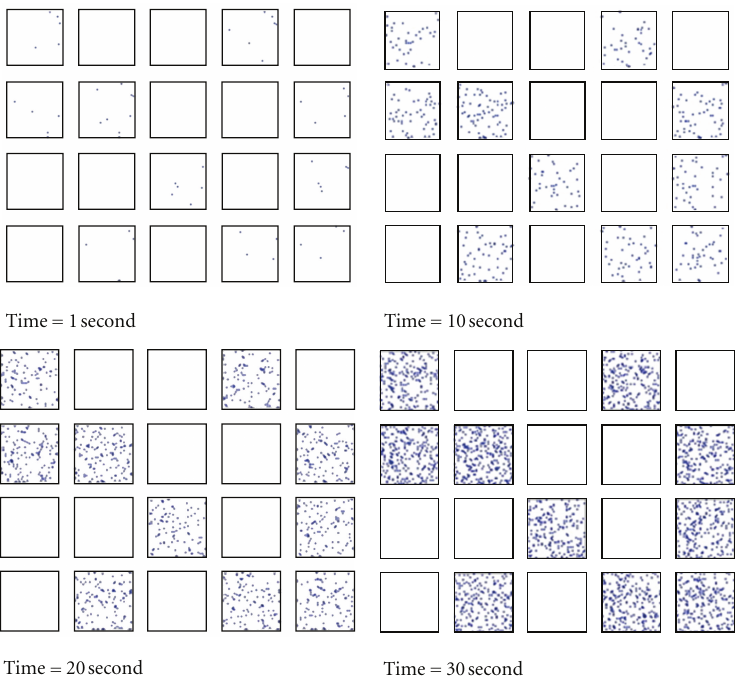
Figure 2: Four screen shots showing a decision challenge with ten alternatives at di ff erent time periods. As time progresses each of the active squares fill with dots based on independent probability distributions. In this case, the correct alternative is the square in the second column of the second